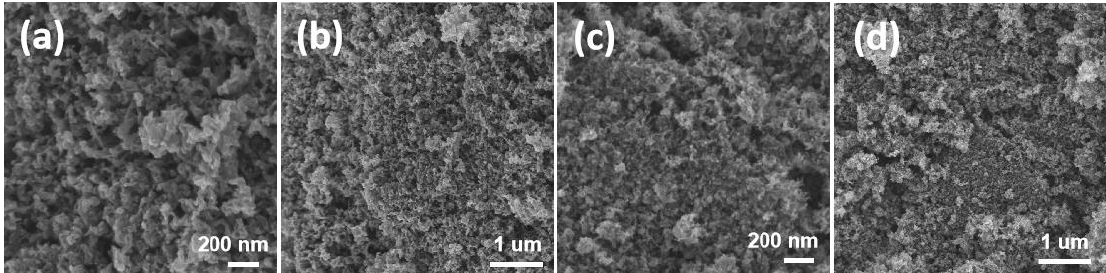
Figure 2. FESEM images of samples 1 and 6 ( a , b ): sample 1 and ( c , d ): sample 6. Transmission electron microscopy (TEM) images revealed the presence of Co-Fe NPs.